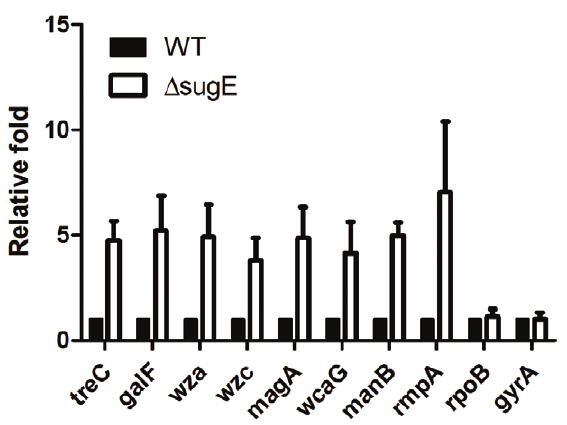
Figure 8. The transcriptional levels of treC and capsule- associated genes in the sugE mutant. Total RNA was extracted from K. pneumoniae NTUH-K2044 wild-type strain (WT) and D sugE cultivated in LB broth. The expression level of each gene in wild-type strain was taken as basal levels to obtain the value of relative level in D sugE strain. Data shown are the means of 3 independent experiments, and error bars shows the SDs.